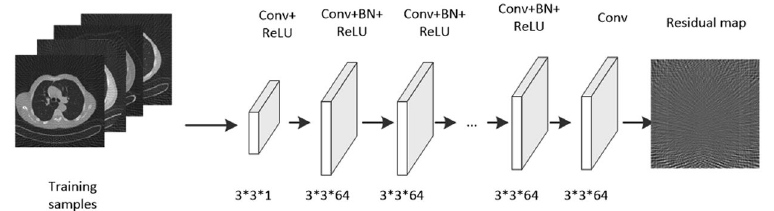
Figure 4. The flowchart of the AFCNN method.